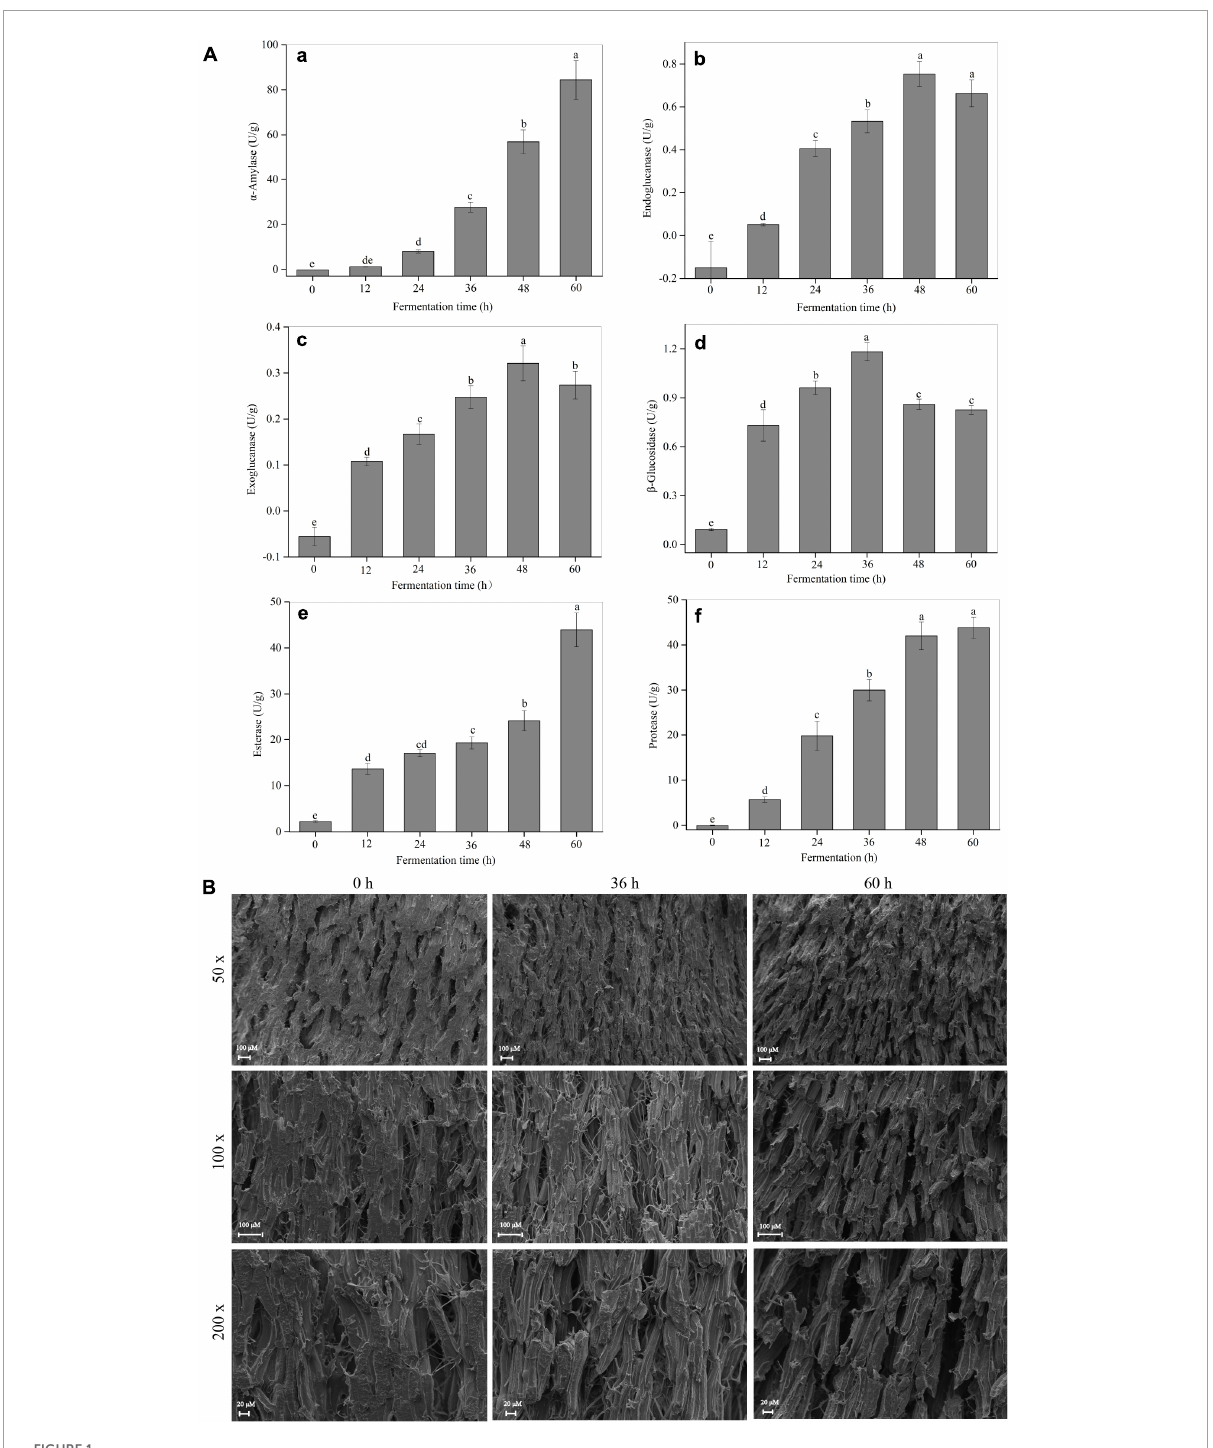
FIGURE1 Changes of microbial enzyme activities and microstructure observation during SSF. (A) a, α -amylase; b, endoglucanase; c, exoglucanase; d, β -glucosidase; e, esterase; f, protease. (B) Microstructure. p < 0.05 was considered as the significant level. The small letters were used to show the significant difference between samples at different fermentation